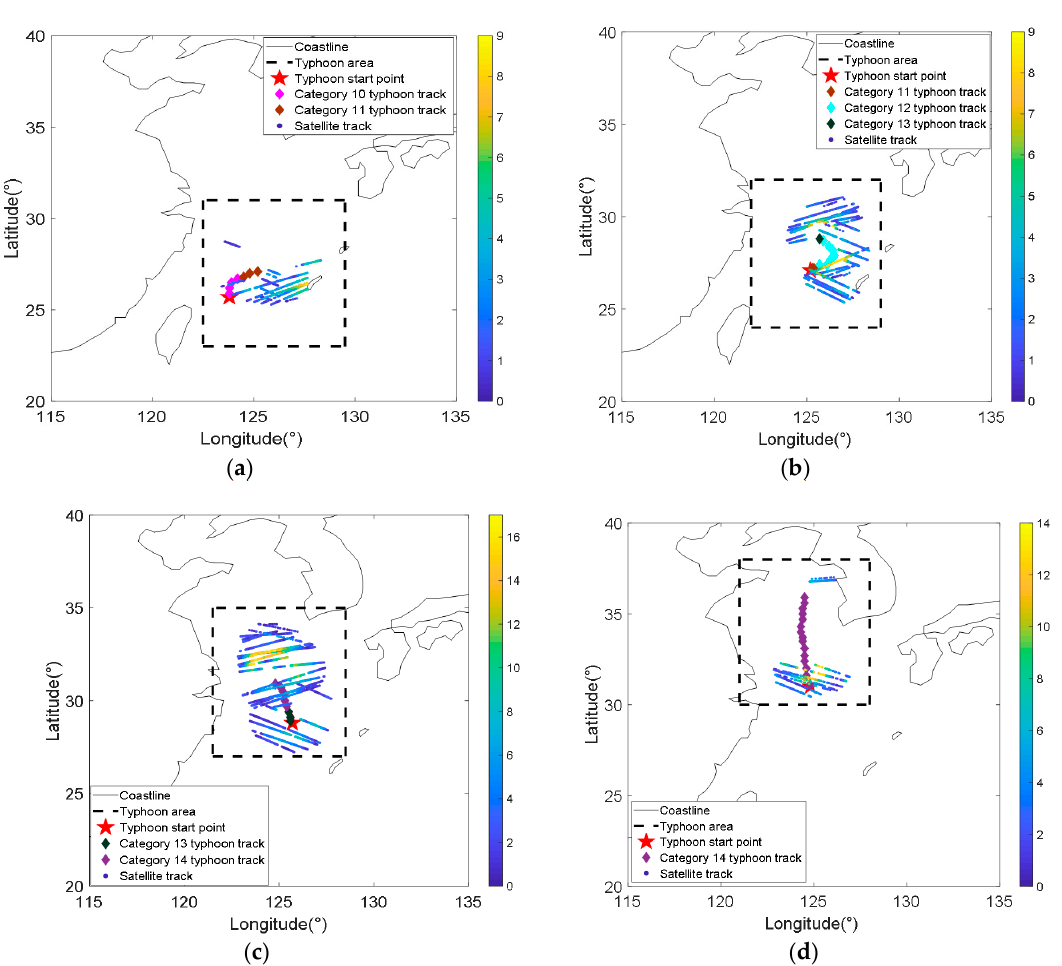
Figure 8. ( a ) 2020.8.23 CYGNSS satellite flight track and corresponding inversion error; ( b ) 2020.8.24 CYGNSS satellite flight track and corresponding inversion error; ( c ) 2020.8.25 CYGNSS satellite flight track and corresponding inversion error; ( d ) 2020.8.26 CYGNSS satellite flight track and corresponding inversion error. The color bar on the right represents the wind speed value, Unit: